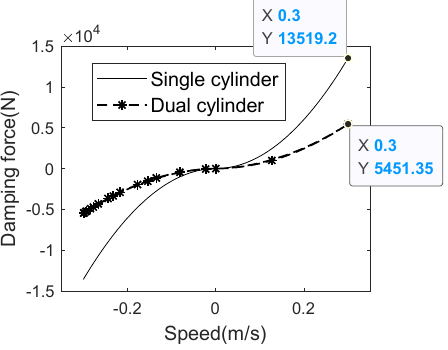
Figure 8. The comparison curve of damping force and velocity.